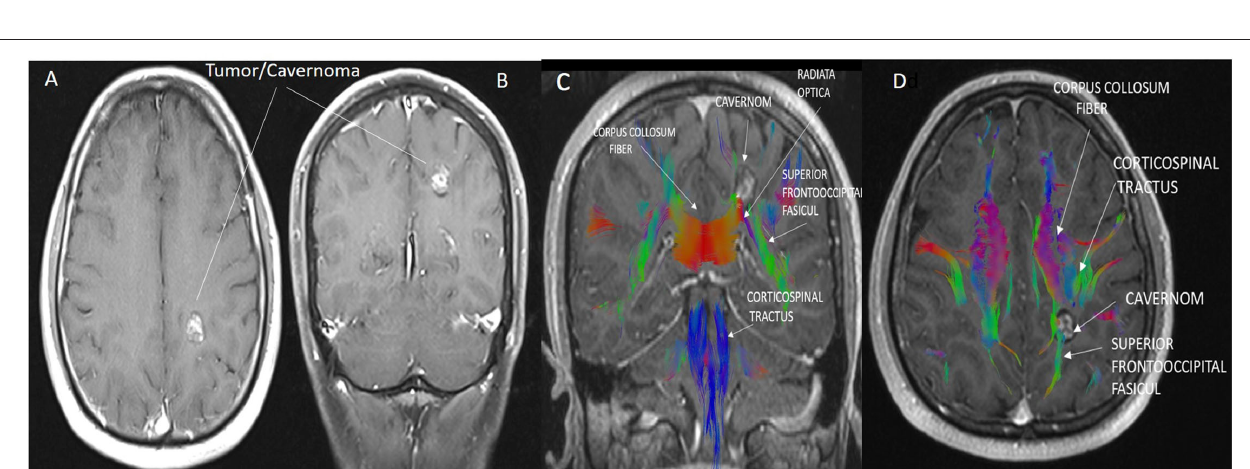
FIGURE 1 | The proposed system architecture for finding linear and nonlinear access paths for neurosurgery.